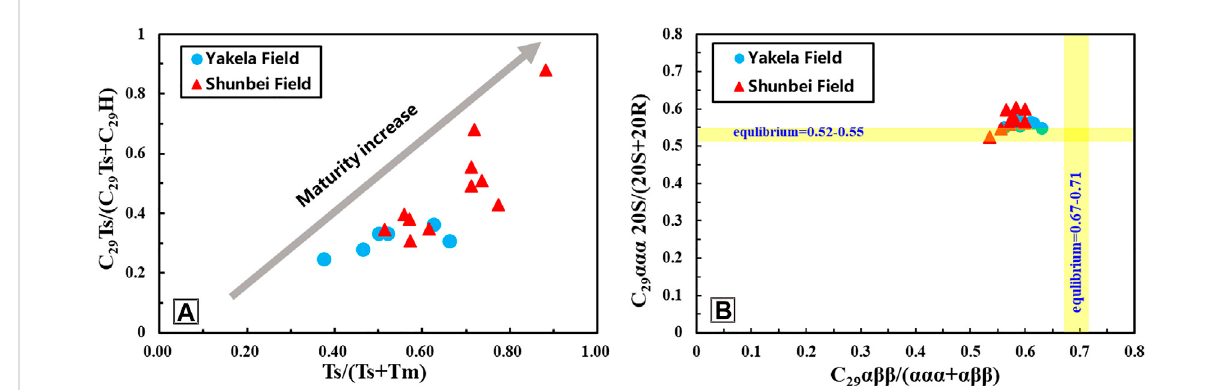
FIGURE 5 CrossplotshowingthematurityoftheoilsinYakelaFieldandShunbei Field,TarimBasin. (A) CrossplotofC 29 Ts/(C 29 Ts+C 29 H)andTs/(Ts+Tm); (B) Cross plot of C29 ααα 20S/(20S+20R) sterane and C29 αββ /( ααα + αββ ) sterane.